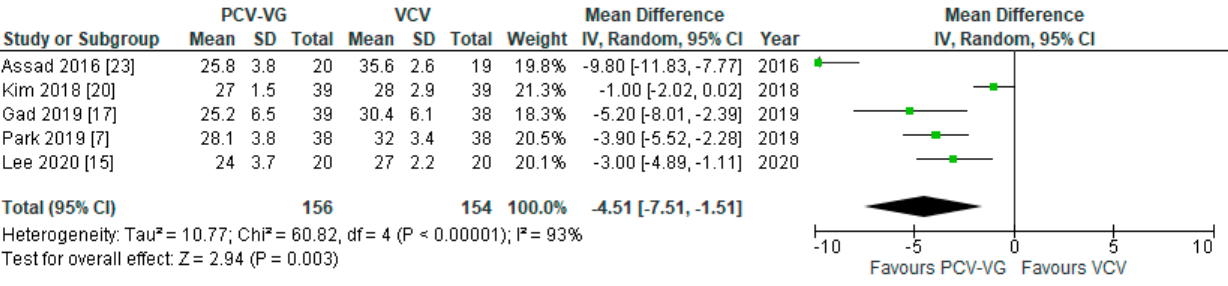
Figure 12. Peak airway pressure (P peak ): after 60 min of Trendelenburg position. The green center of each square represents the weighted mean difference for individual trials, and the corresponding horizontal line stands for a 95% confidence interval. The diamonds represent pooled results.